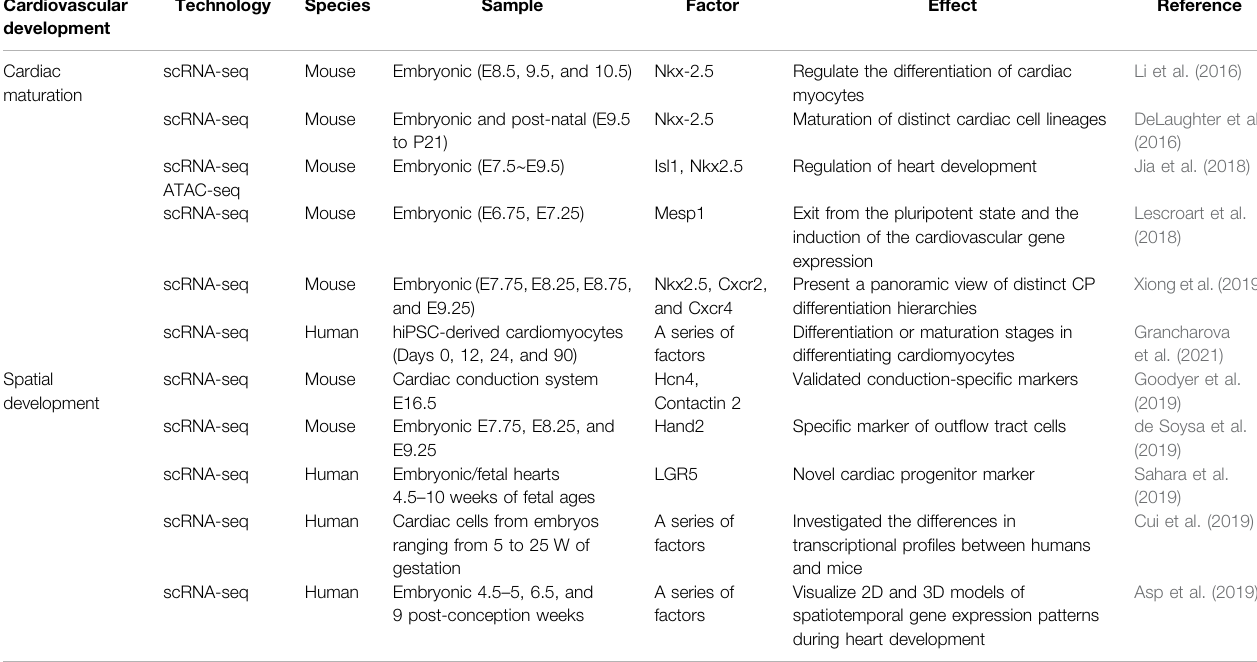
TABLE 1 | scRNA-seq and cardiovascular